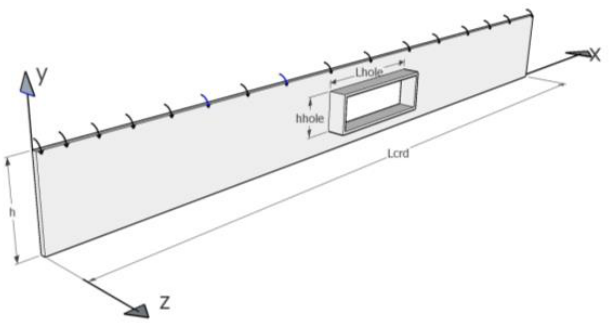
Figure 5. Apply a line moment to the upper side of the plate with an edge-stiffened hole.